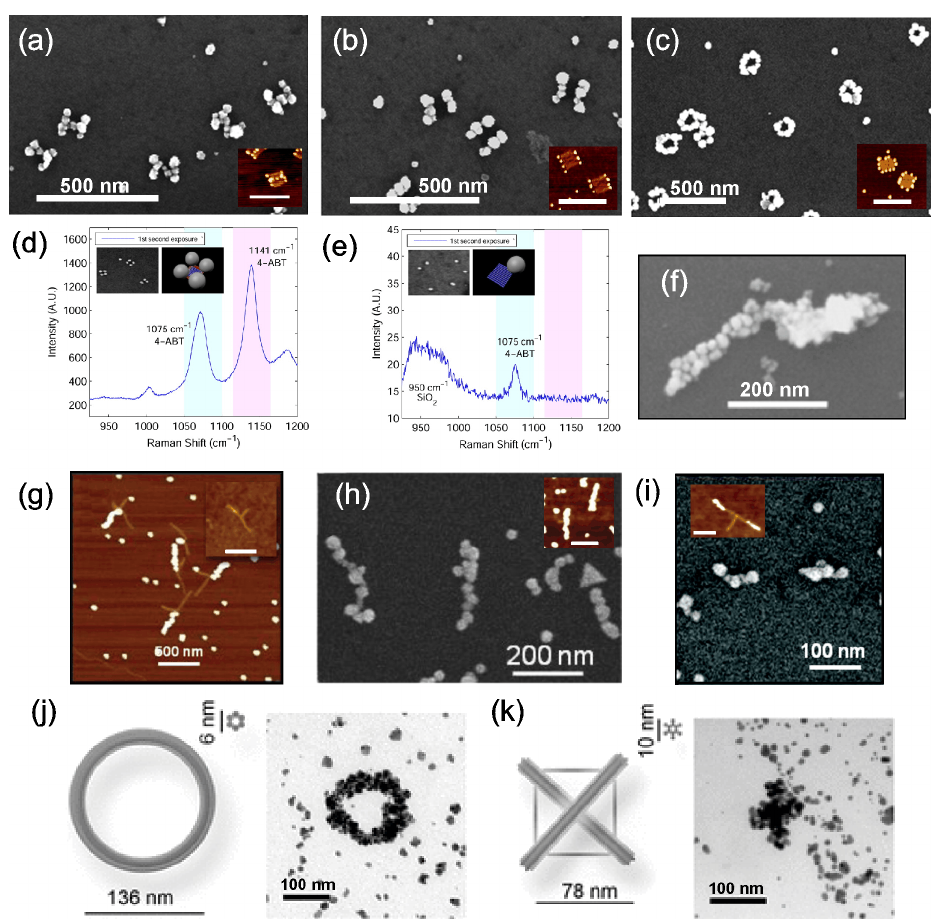
Figure 4. ( a – c ) Metallized H-shapes, two parallel bars and rings. Insets are the corresponding structures before metallization, scale bars are 250 nm [93]. ( d ) SERS spectrum of aminobenzenethiol obtained by using the four-corner bound AuNPs structure (inset) for enhancement of the Raman signal. ( e ) Structures with just a single AuNP resulted in an insignificant SERS signal [94]. ( f ) A single origami bar metallized with both gold and copper on either side [96]. ( g – i ) T-shaped DNA structures with AuNPs bound to one branch, both branches (inset in (h)) and only on the edges of the T-branches (inset in (i)). The structures in the insets of (h) and (i) were further metallized into continuous metal structures as shown in (h) and (i). Scale bars in insets of (g) and (h) are 500 nm and of (i) 100 nm [91].